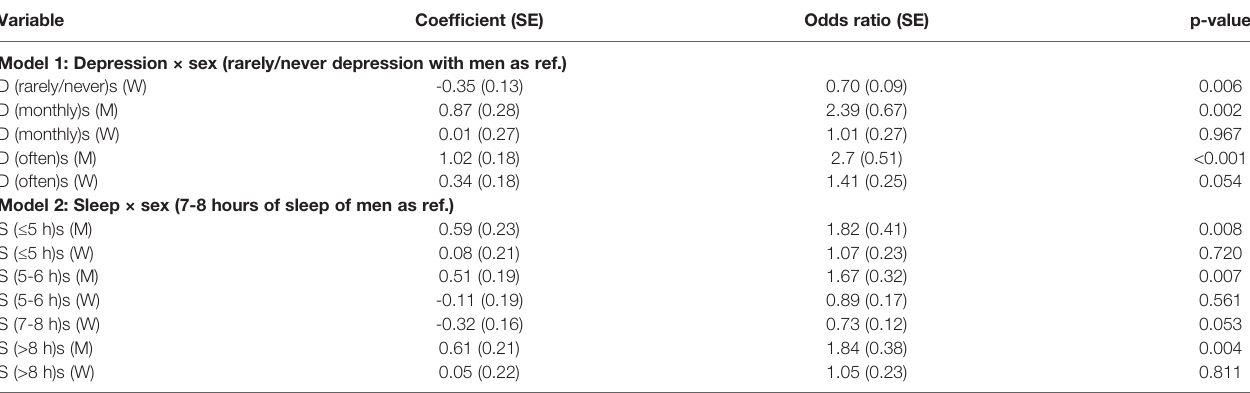
TABLE 4 | The effects of depression and sleep interaction with sex on the probability of diabetes (Model 1 and 2). Variable Coef fi cient (SE) Odds ratio (SE) p-value Model 1: Depression × sex (rarely/never depression with men as ref.) D (rarely/never)s (W)